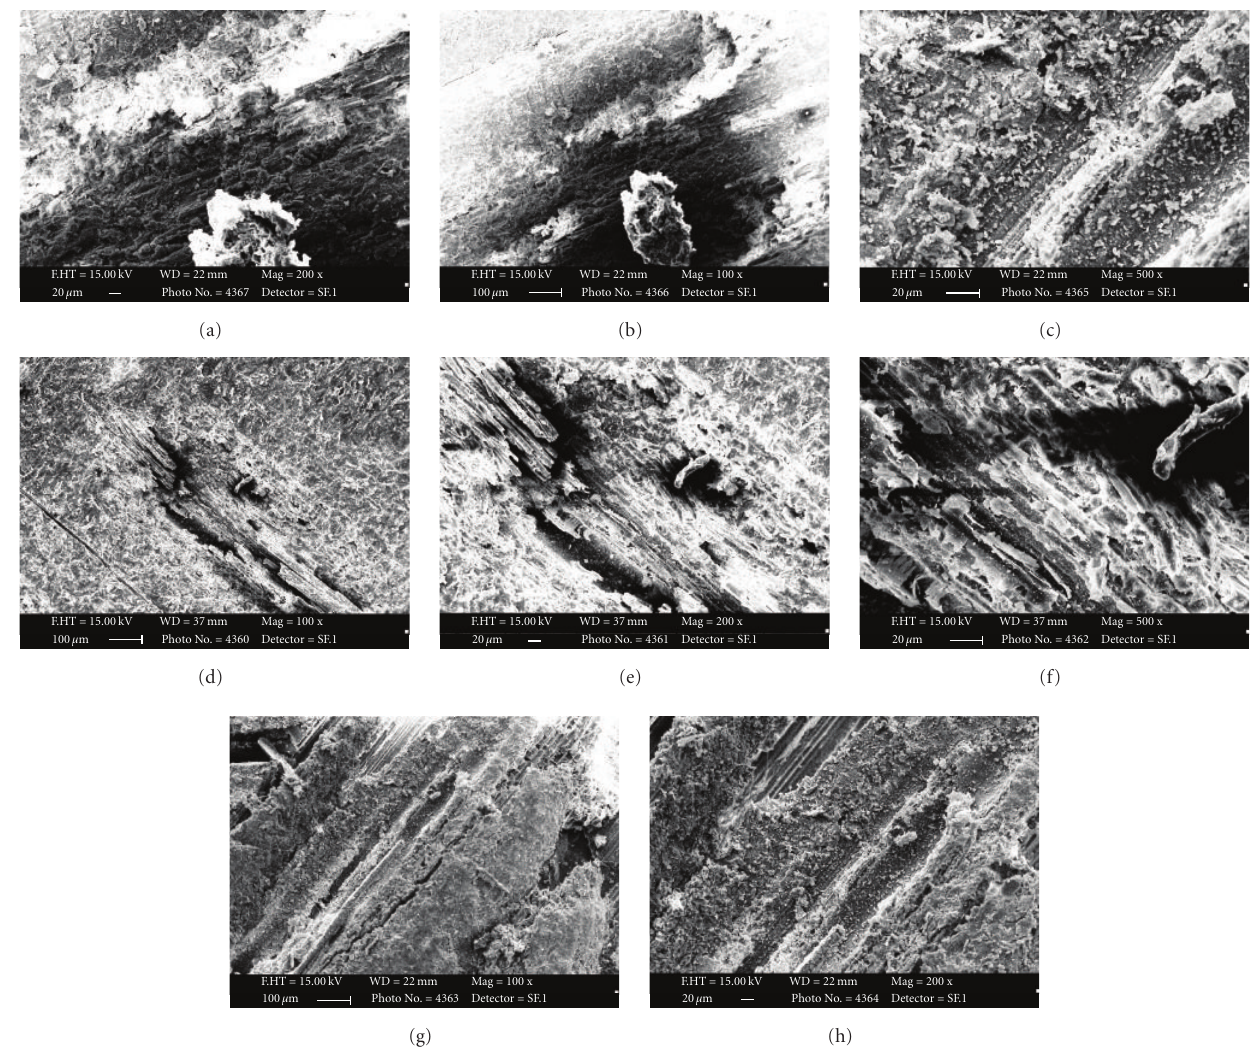
Figure 8: SEM observations of eroded samples with the variations of impingement